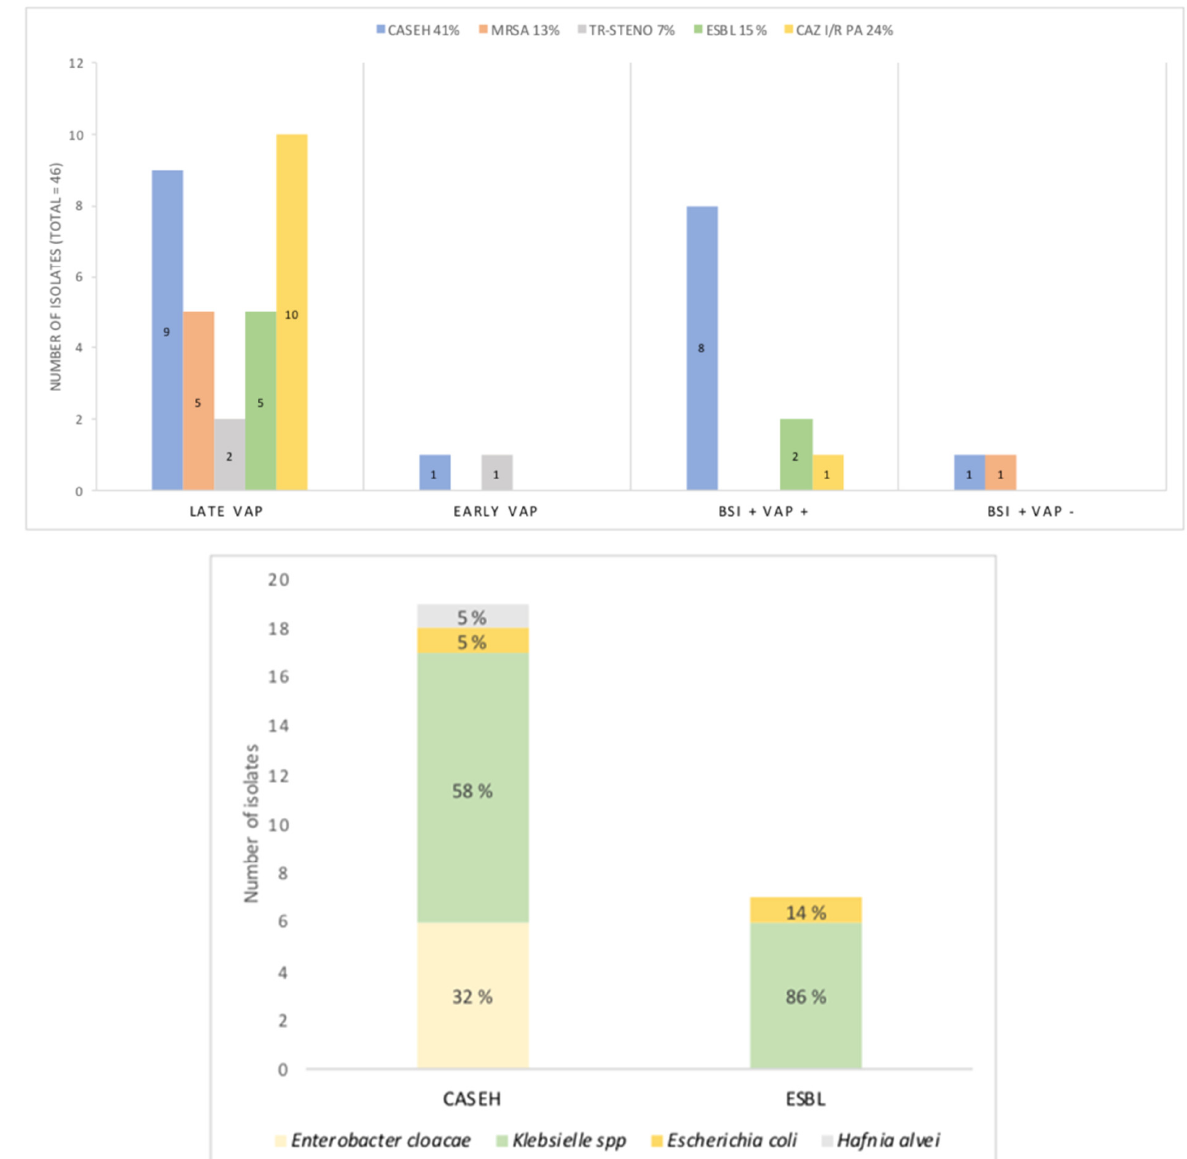
Figure 2. Ventilation-acquired pneumonia bacterial documentation .